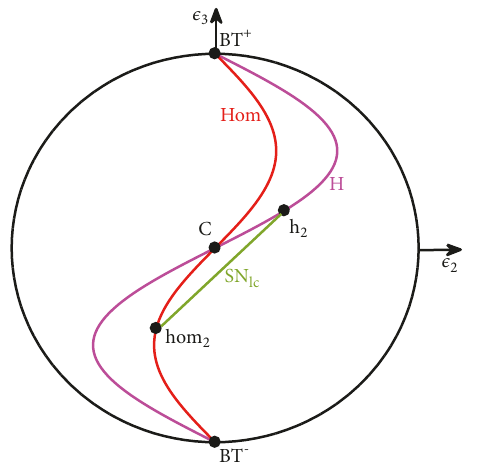
Figure 3: Intersection of the bifurcation diagram of the cusp type of BT bifurcation of codimension 3 with the 2-sphere 𝑆